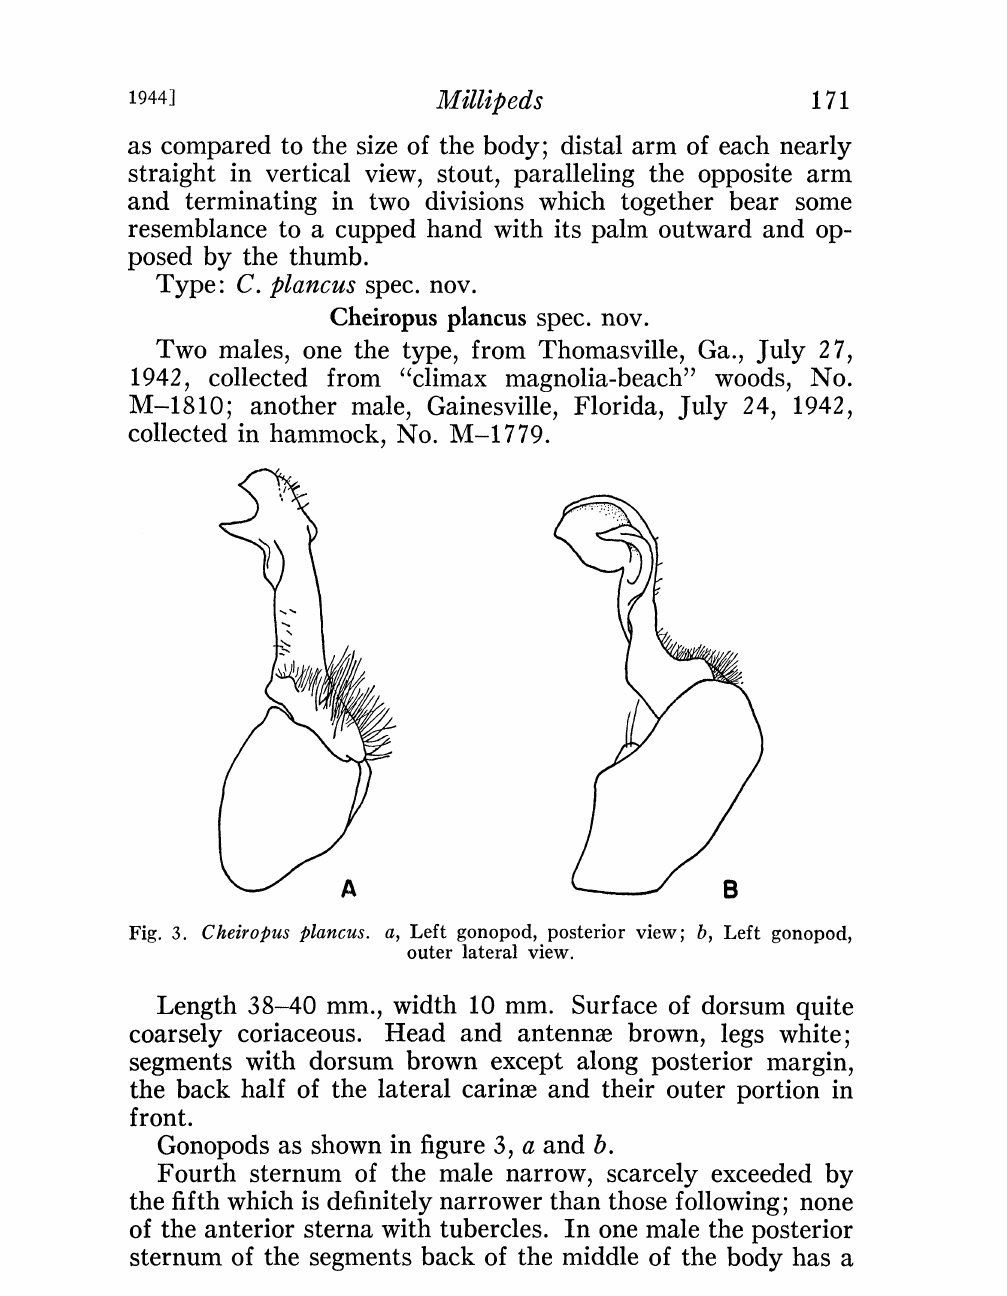
Fig. 3. Cheiropus plancus, a, Left gonopod, posterior view; b, Left gonopod, outer lateral view. Length 38-40 mm., width 10 mm. Surface of dorsum quite coarsely coriaceous. Head and antennre brown, legs white; segments with dorsum brown except along posterior margin, the back half of the lateral carine and their outer portion in